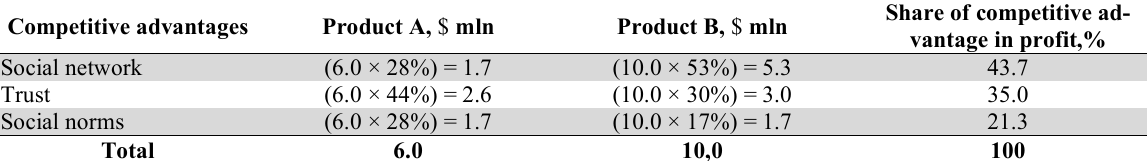
Profit sharing for competitive advantage Competitive advantages Product A, $